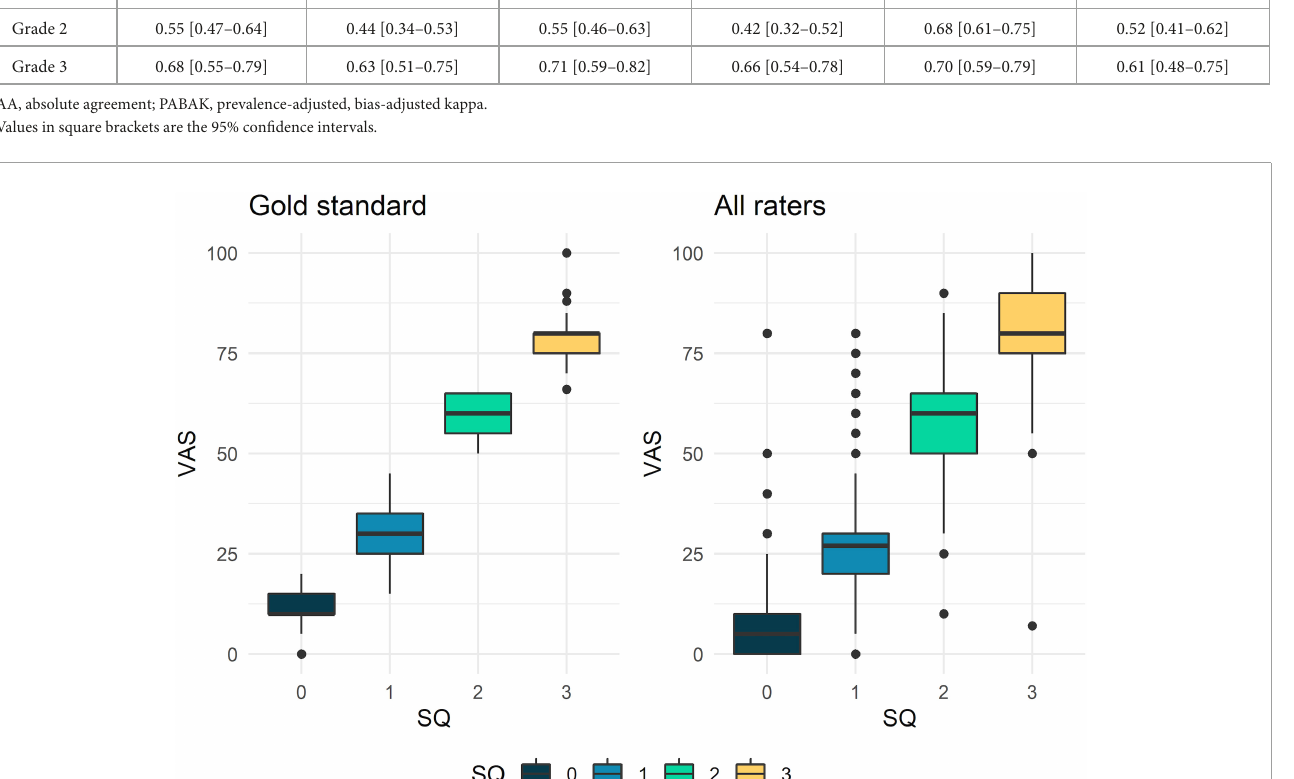
using an ad hoc developed dataset of US images and videos acquired in patients with rheumatic